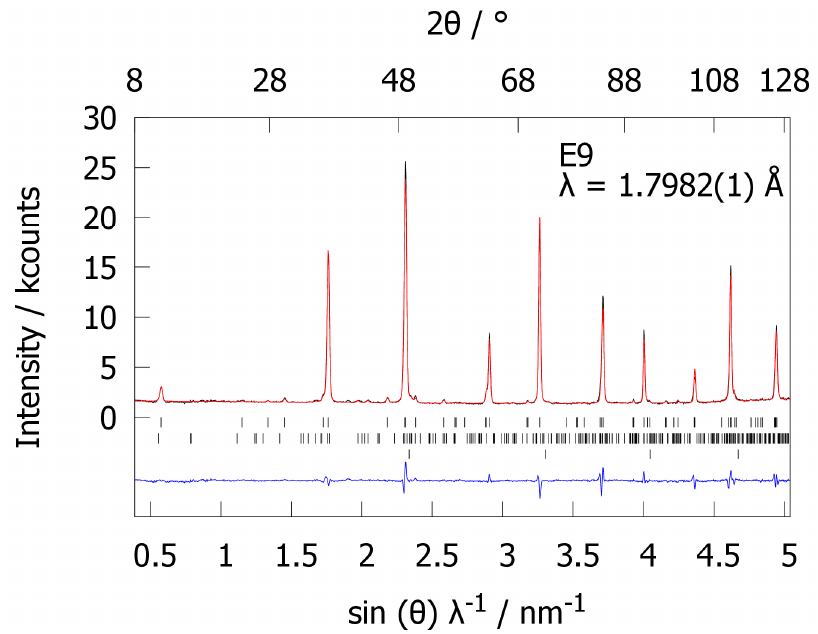
Figure 2. Rietveld refinement of the crystal structure of LaGa 2 D 0.71(2) based on powder neutron diffraction data (black, E9 at Helmholtz-Zentrum Berlin; red: calculated pattern), R p = 3.96%, R wp = 5.55%, Bragg makers from top to bottom: LaGa 2 D 0.71(2) (97.2(8)%), LaGaD x (2.8(2)%), V (sample container); the difference plot is depicted in blue.